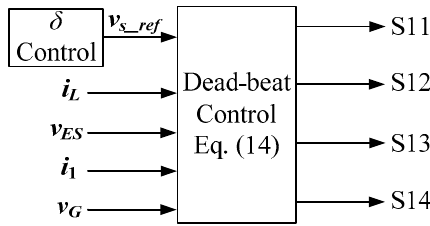
Figure 3. The proposed dead-beat control based on the δ control.